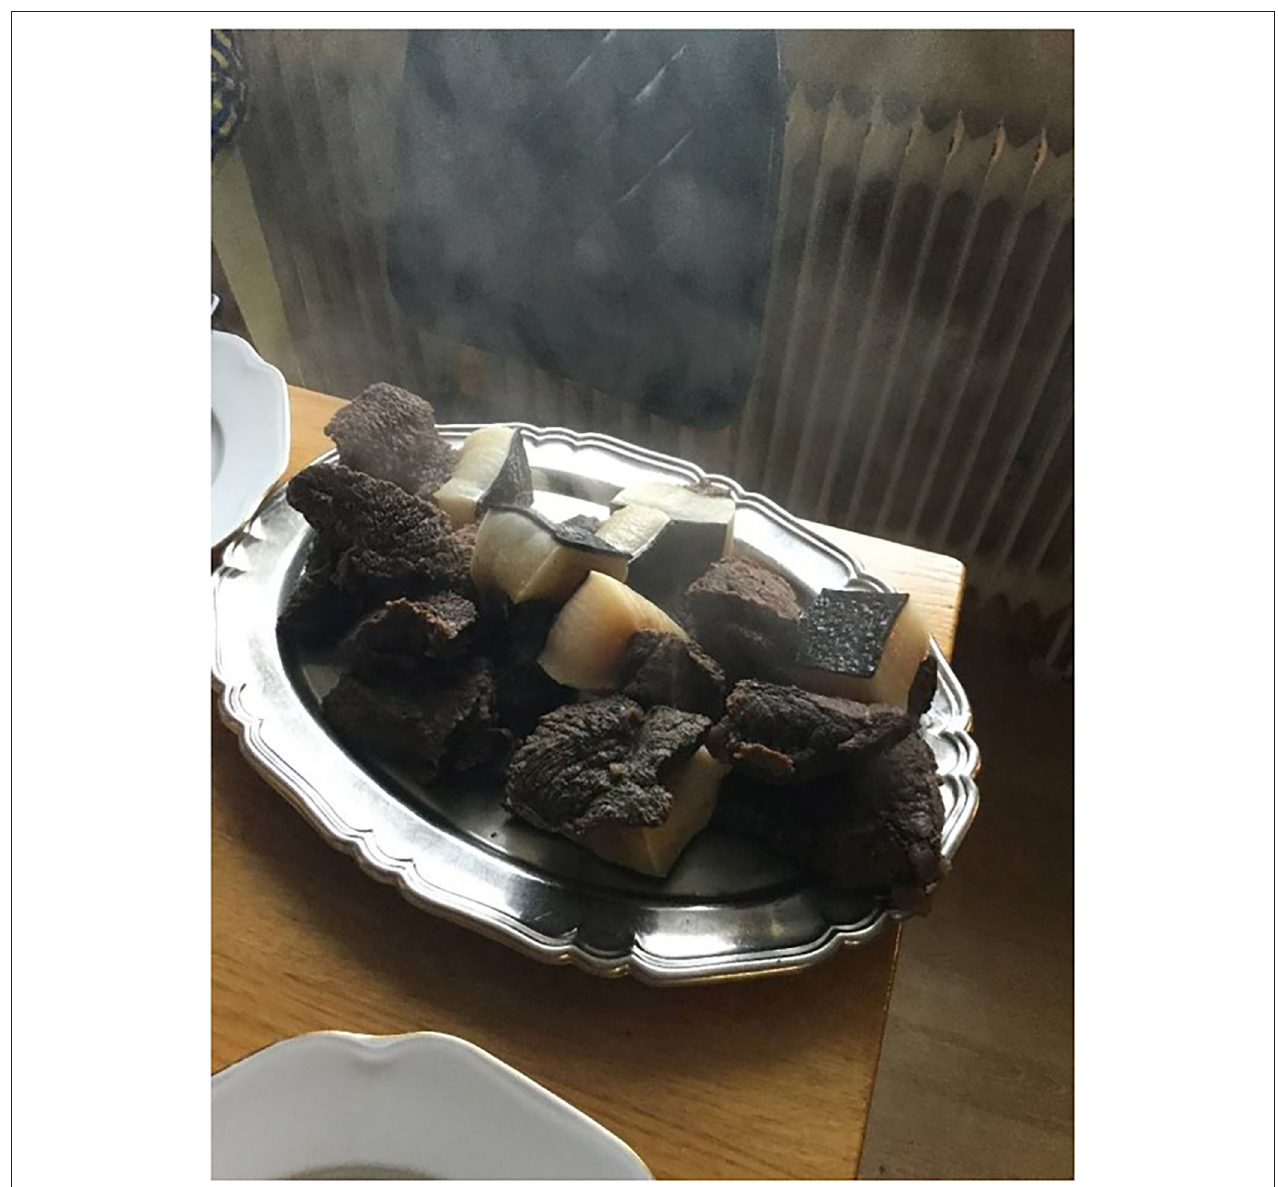
FIGURE 3 | Boiled whale meat and blubber (Photo Ingvar